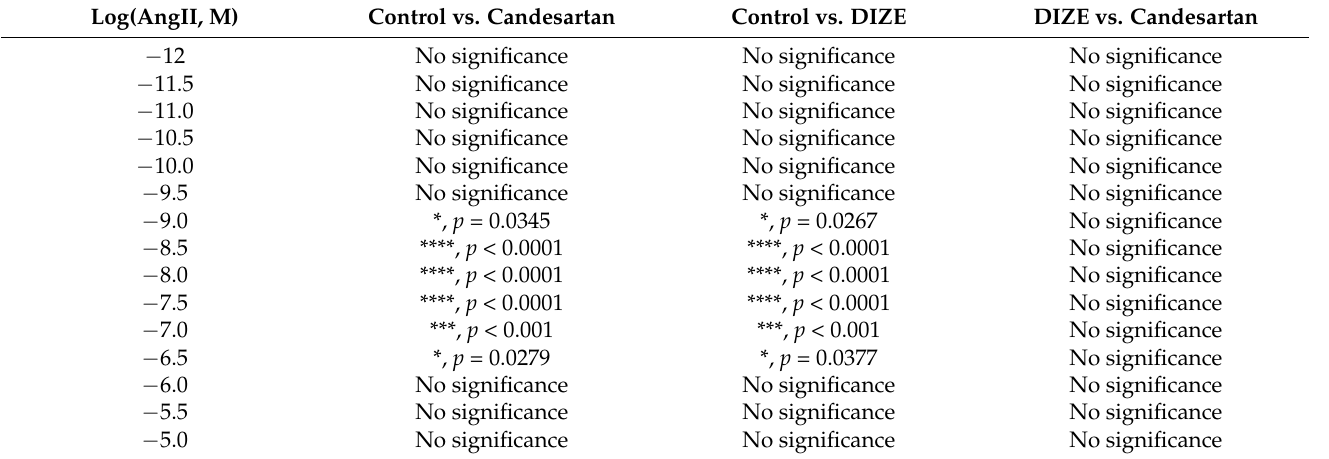
Table 1. Significance of vasoconstriction in response to the AngII dose response between the control, candesartan and DIZE obtained from Figure